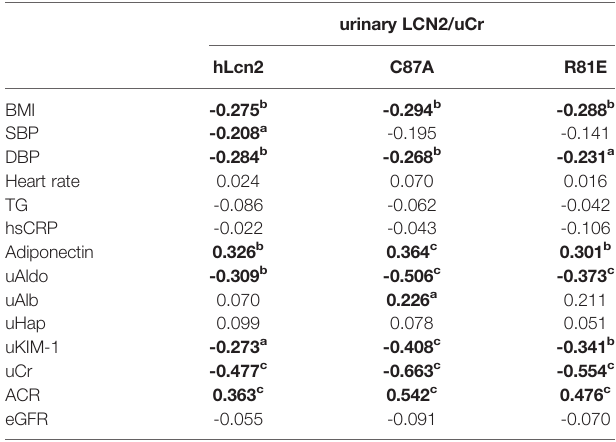
TABLE 6 | Correlations between the urinary LCN2/uCr ratios and cardiometabolic risk factors and renal function..